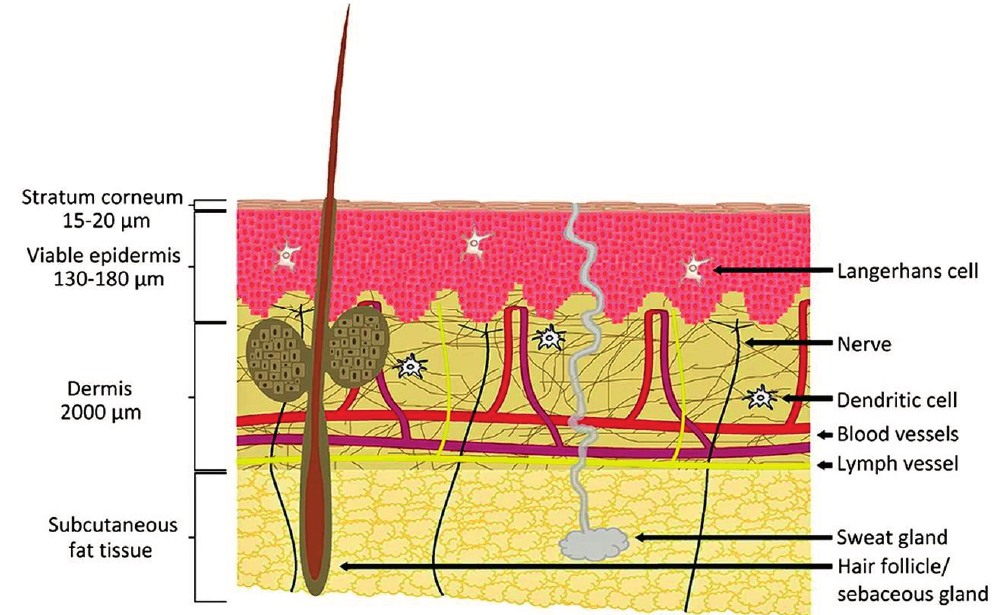
Figure 1. Anatomy of the skin. (Reprinted from [22] with permission. Copyright 2012